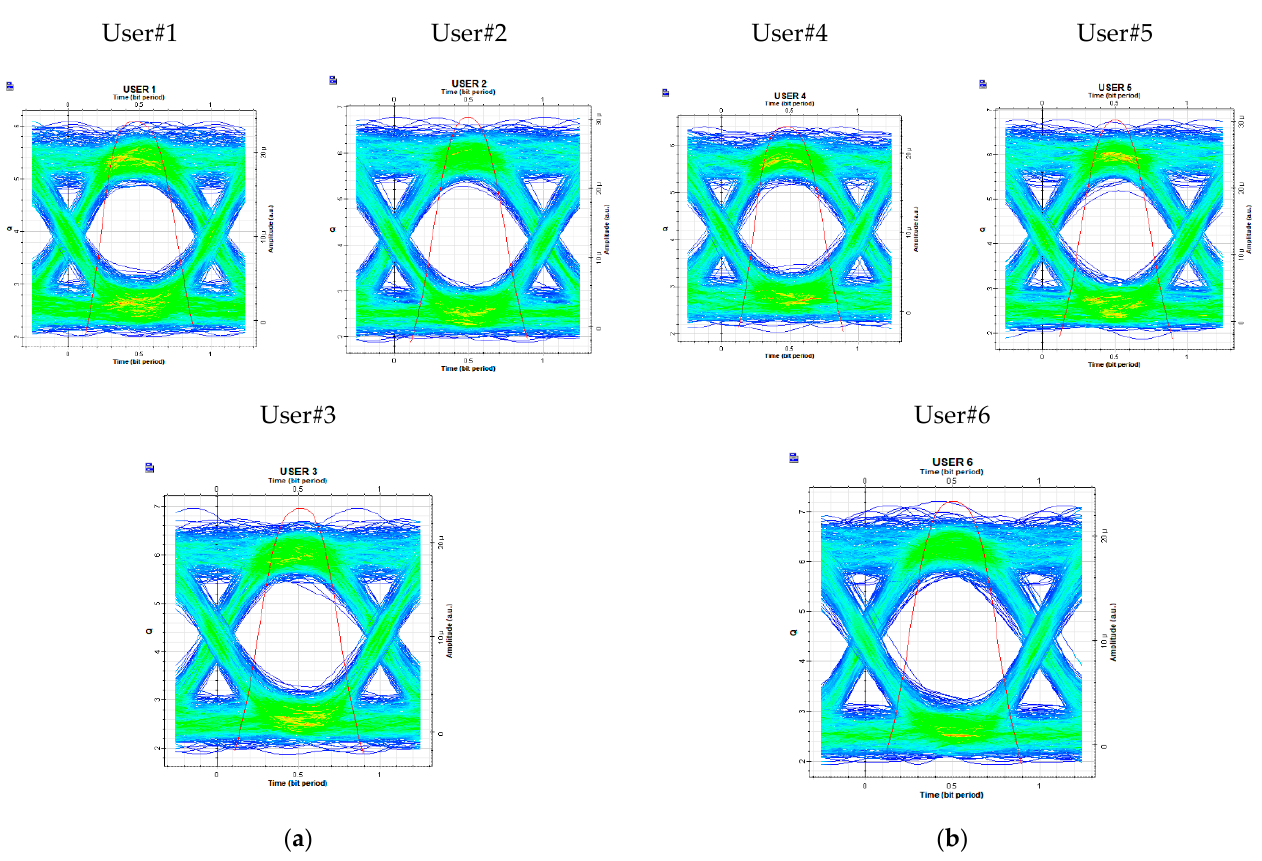
Figure 5. Eye diagrams for PDM-SAC-OCDMA-enabled FSO transmission at 10 km under clear weather conditions transmitted on ( a ) X polar and ( b ) Y polar .